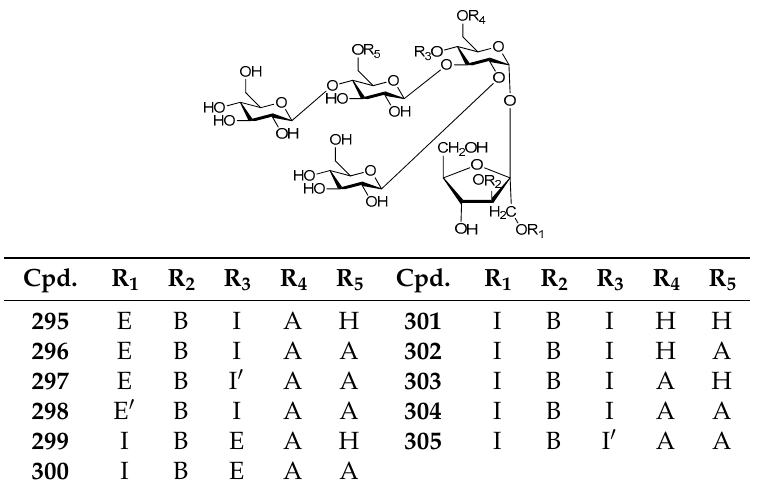
Figure 61. Structures of compounds 280 – 294 .